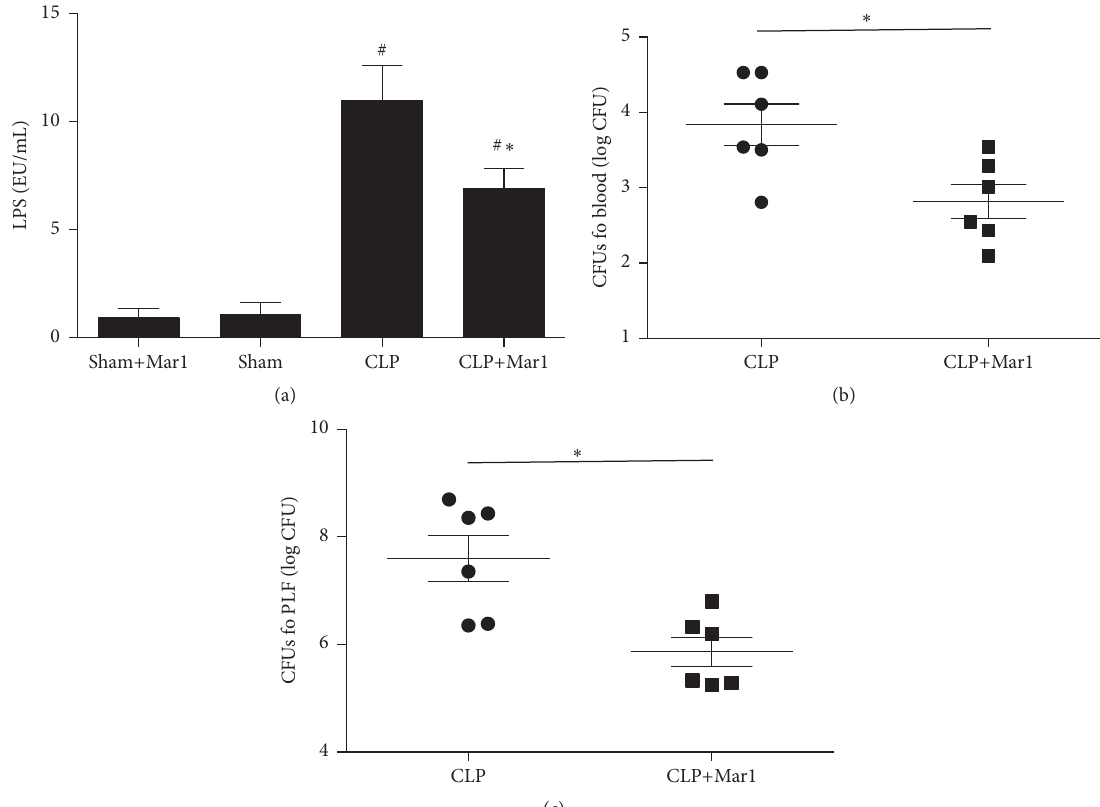
Figure 2: Mar1 decreased LPS and bacterial burden in CLP mice. (a) The level of serum LPS in CLP mice. The CFUs (colony-forming units) in blood (b) and in peritoneal lavage (c) in CLP mice. Data are expressed as means ± SEM. 𝑛 = 6 . # 𝑃 < 0.05 versus the sham group. ∗ 𝑃 < 0.05 versus the CLP